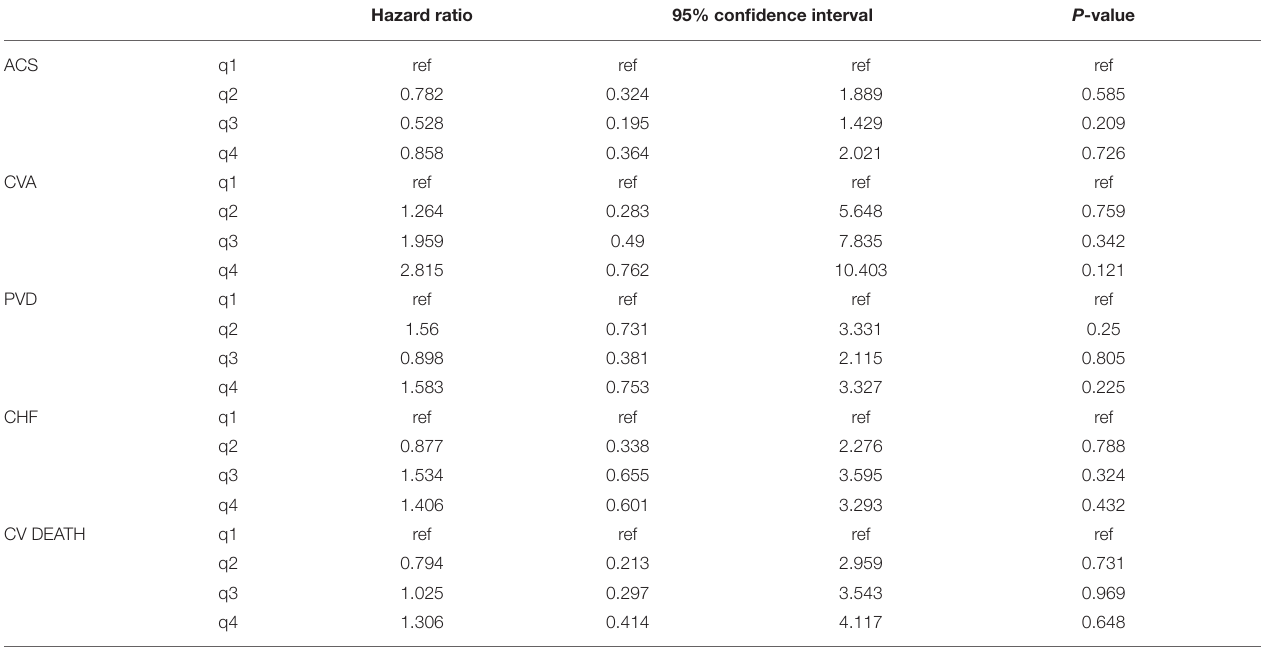
TABLE 4 | Association between quartiles of TWA of sMg and the separate components of MACE.